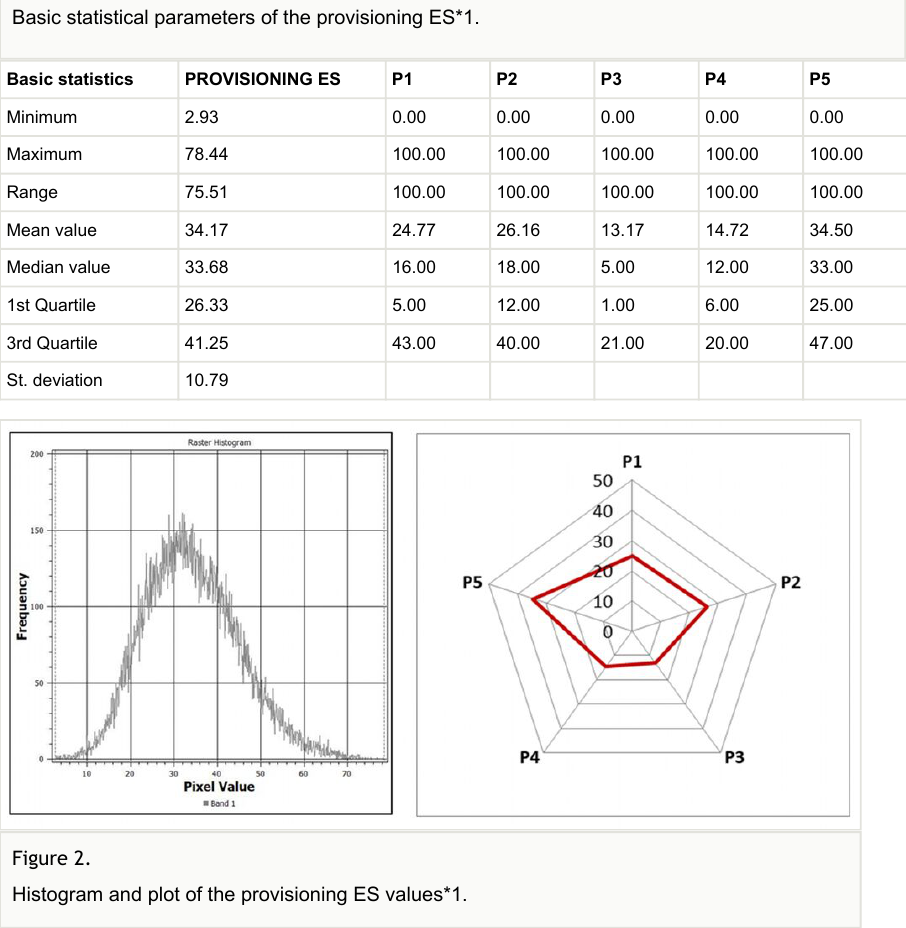
Figure 2. Histogram and plot of the provisioning ES